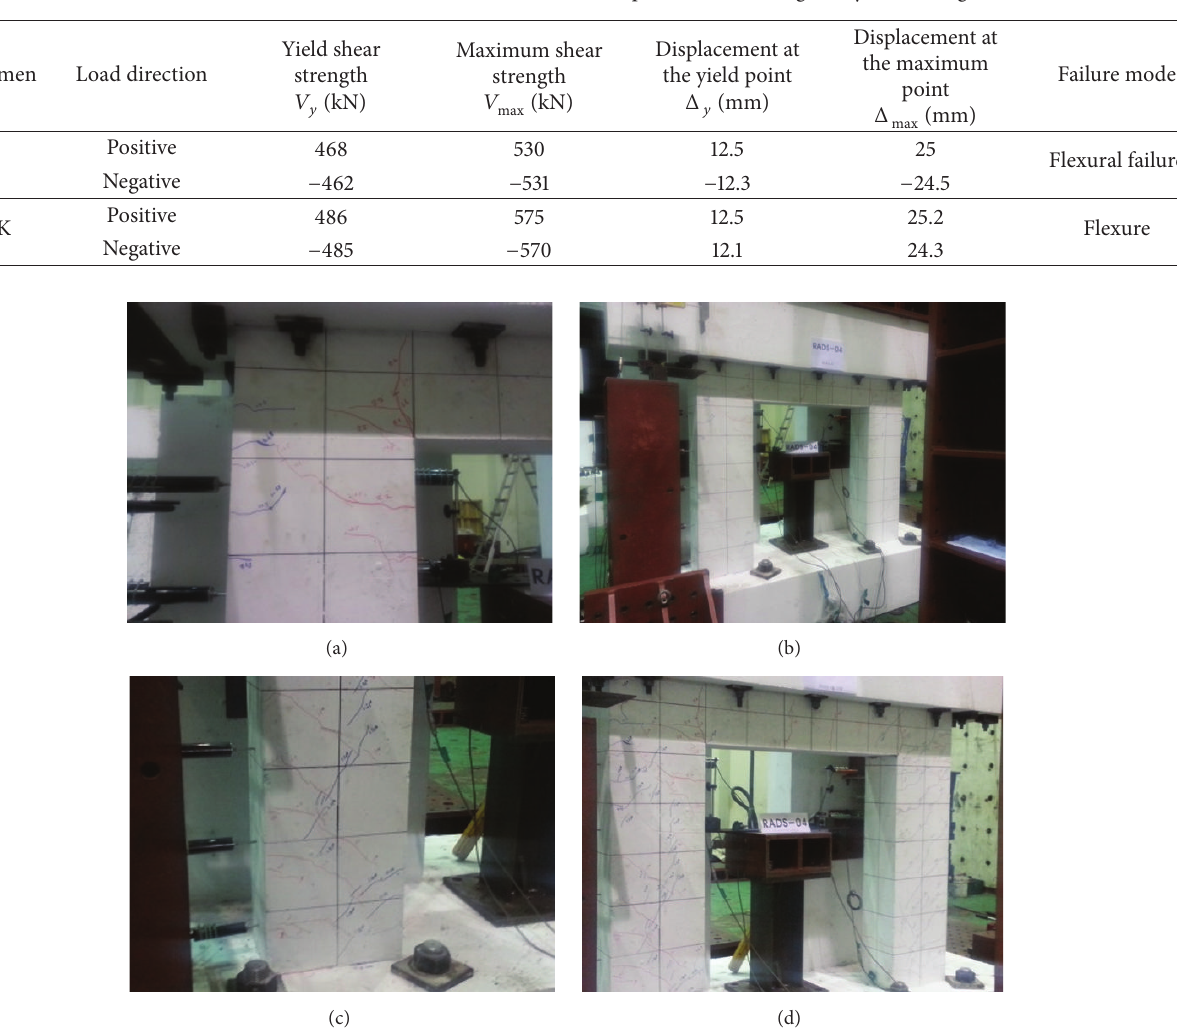
Table 5: Results of mechanical characterizations of test specimens following the cyclic loading test.